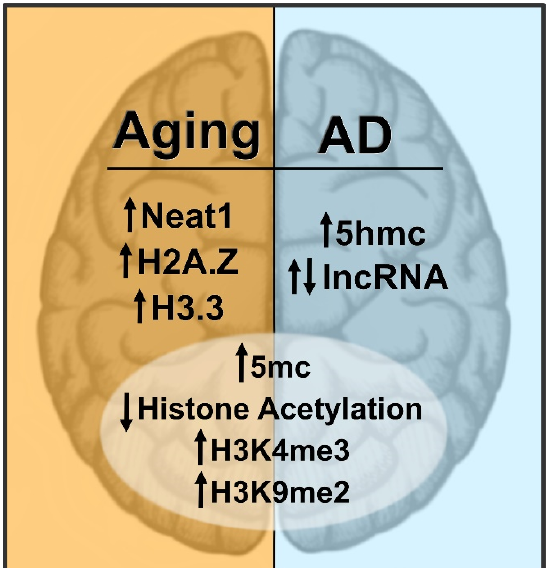
Figure 2 . Epigenetic marks altered in the brain during Alzheimer’s disease (AD) compared to normal aging. This figure compares several epigenetic marks dysregulated in the brain of AD patients and rodent models with that of normal aging. The marks that change similarly in both conditions are in the circle and marks that change only in one condition are listed separately. The arrows show the direction of the marks’ changes.